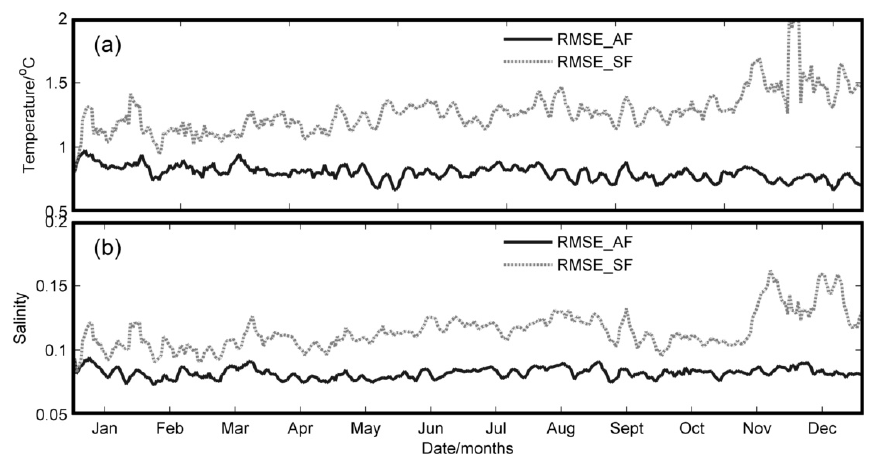
Figure 6. Temporal evolution of temperature ( a , in ◦ C) and salinity ( b , in psu). The RMSE is computed against the Argo profiles for the AF (black solid line) and SF (gray dotted line).